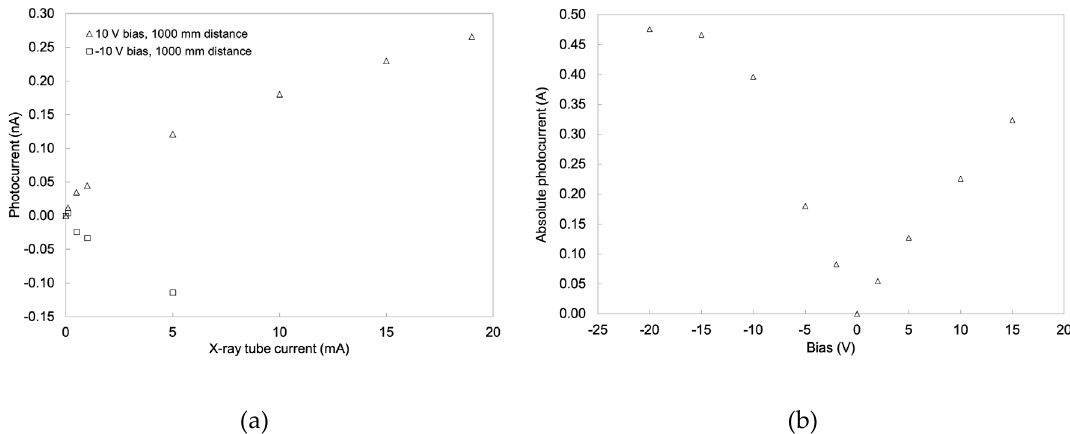
Figure 5. Dependence of the photocurrent on the X-ray tube current at +10 V and − 10 V for the Exp4 sample-to-source separation of 1000 mm ( a ). Relationship between the Exp4 sample current and the Exp4 sample bias determined at 5 mA X-ray tube current and the sample-to-source separation of 1000 mm ( b ).